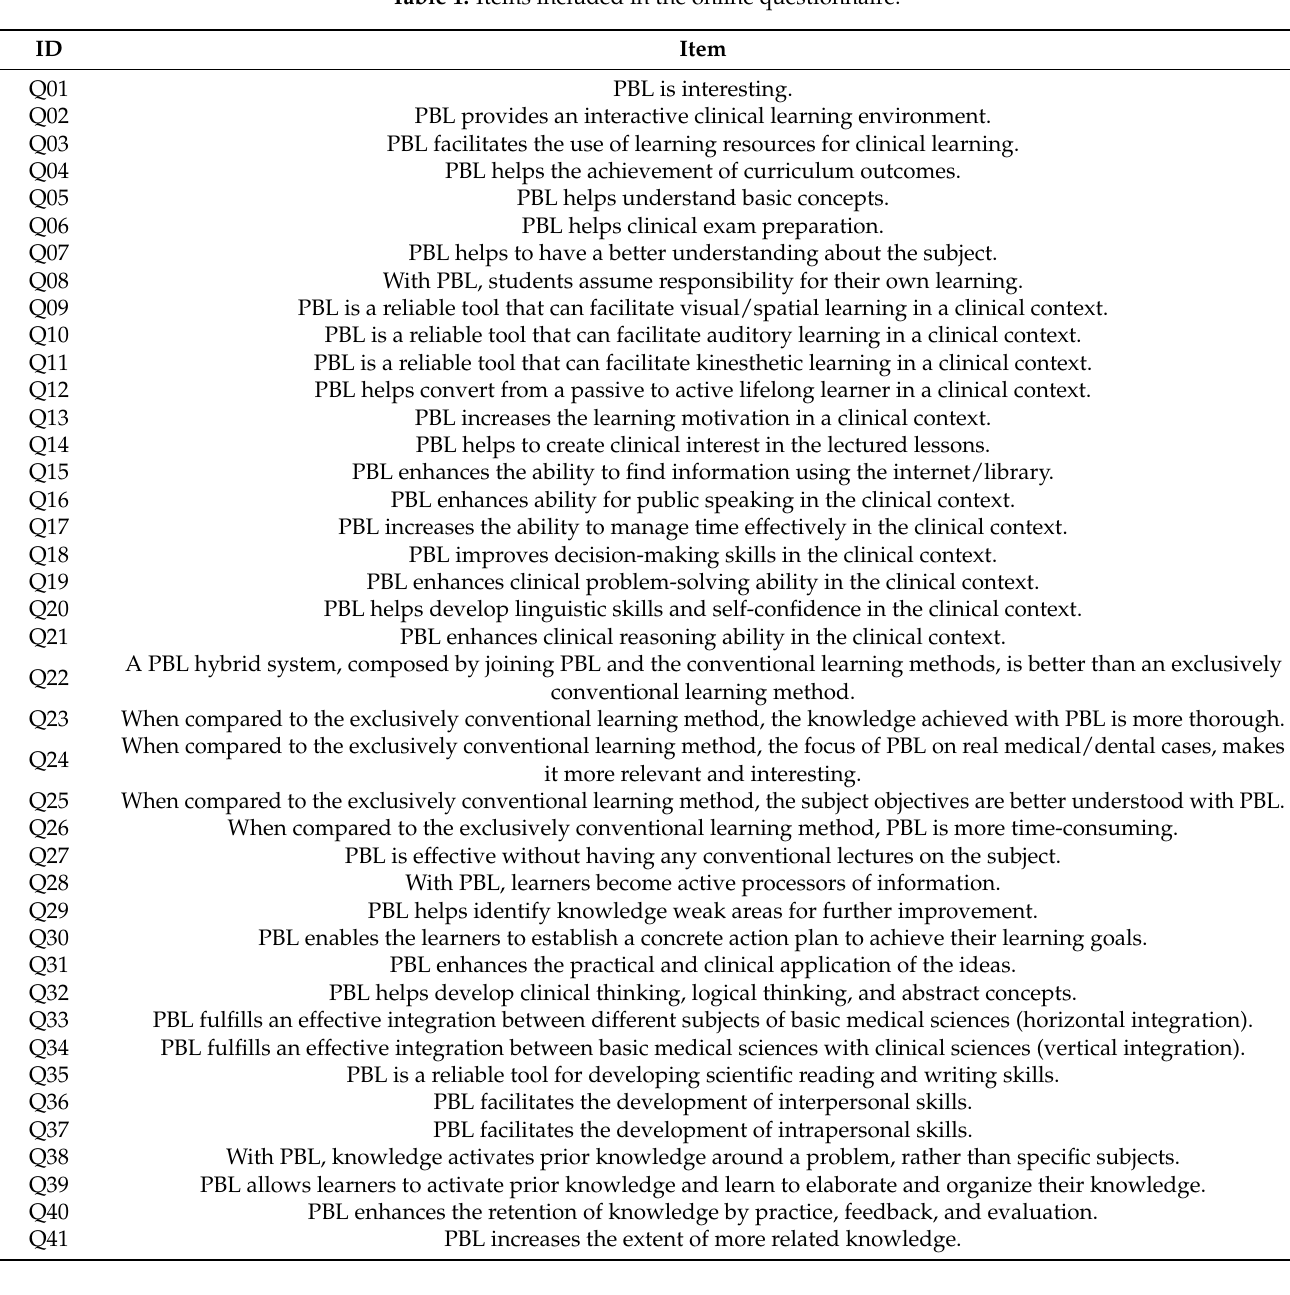
Table 1. Items included in the online